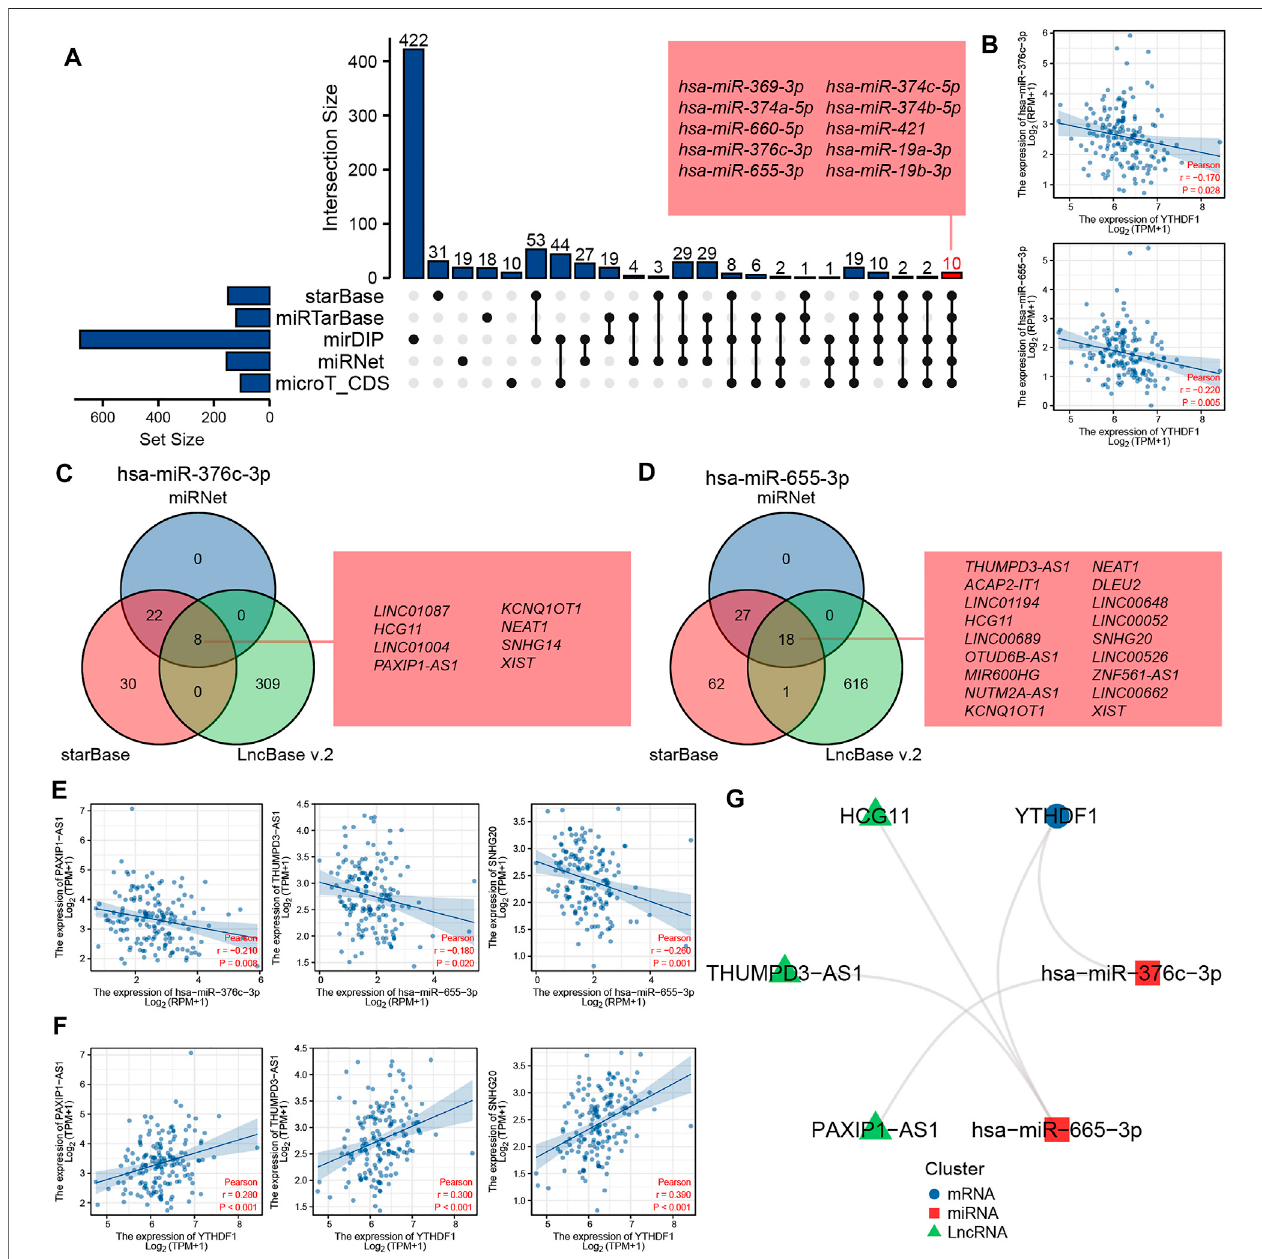
FIGURE 9 | The ceRNA network of YTHDF1 was predicted and constructed in esophageal carcinoma (ESCA). (A) The UpSetR diagram displays the miRNA of targetedYTHDF1predictedbythestarBase,miRTarBase,mirDIP,miRNet,andmicroT_CDStools. (B) ThescatterplotshowstwomiRNAs(hsa-miR-376c-3pandhsa- miR-655-3p) that are signi fi cantly negatively correlatedwithYTHDF1expression. (C) The Venn diagram displays lncRNAoftargeted hsa-miR-376c-3p predictedby the miRNet, starBase, and LncBase v2.0 tools. (D) The Venn diagram displays lncRNA of targeted hsa-miR-655-3p predicted by the miRNet, starBase and LncBase v2.0tools. (E) ThescatterplotshowsthelncRNAsthataresigni fi cantlynegativelycorrelatedwiththecorrespondingmiRNAexpression,respectively. (F) Thescatterplot shows the lncRNAs that are signi fi cantly positively correlated with YTHDF1 expression. (G) The network diagram shows the relationship of the fi nal ceRNA network.